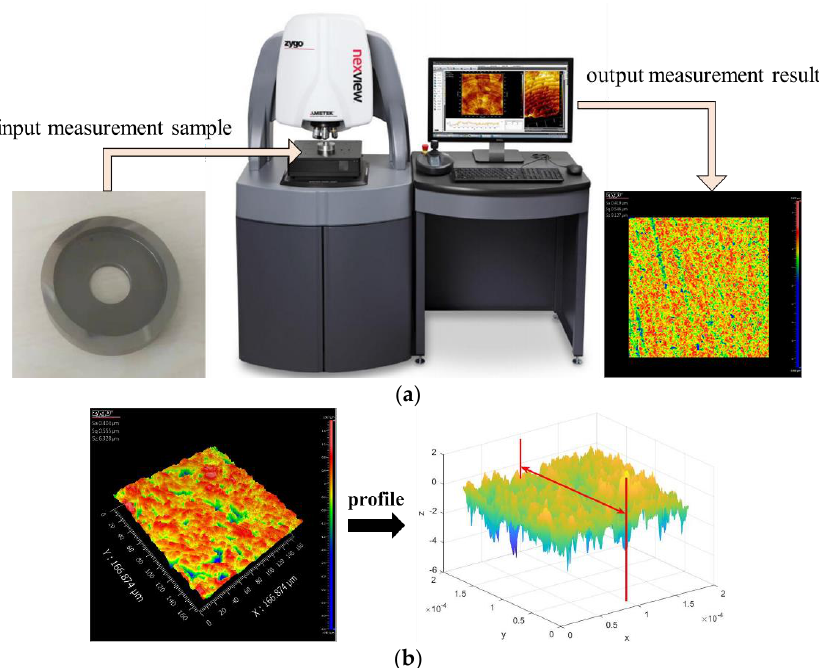
Figure 4. Measurement process of the experiment. ( a ) measurement instrument; ( b ) roughness pro-